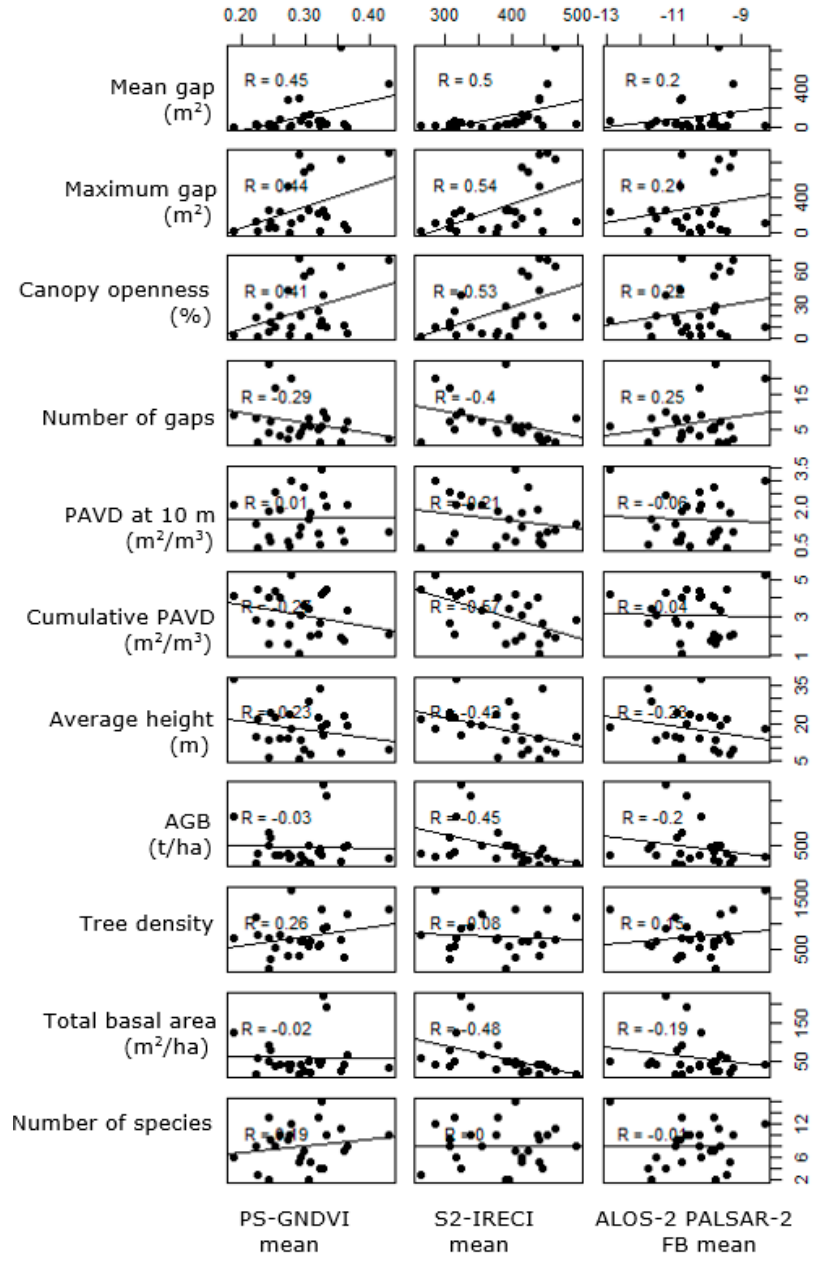
Figure 3. Correlation between field-measured forest structure parameters and most correlated satellite remote sensing variables from optical and synthetic aperture radar domain. PAVD = plant area volume density, AGB = above ground biomass, PS-GNDVI = PlanetScope-derived green normalized difference vegetation index, S2-IRECI = Sentinel-2-derived inverted red-edge chlorophyll index, FB = forest backscatter.